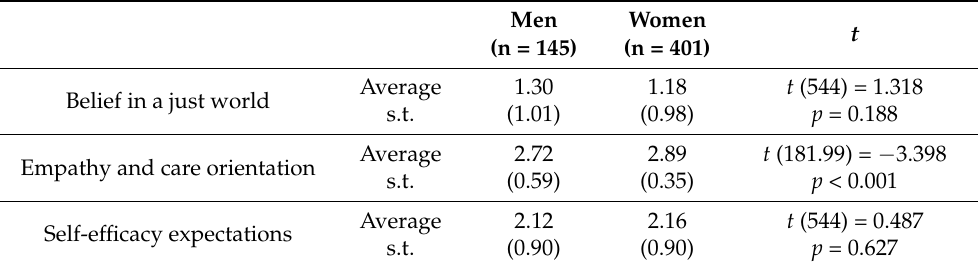
Table 3. Differences in characteristics of the people who help by gender.